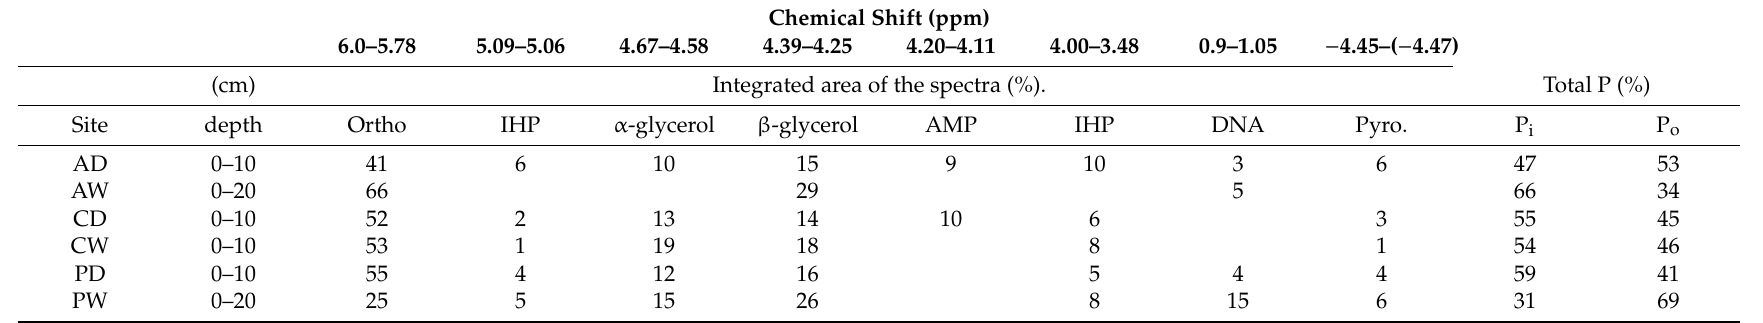
Table 5. Proportions of phosphorus species, P i , and P o determined by the solution 31 P NMR